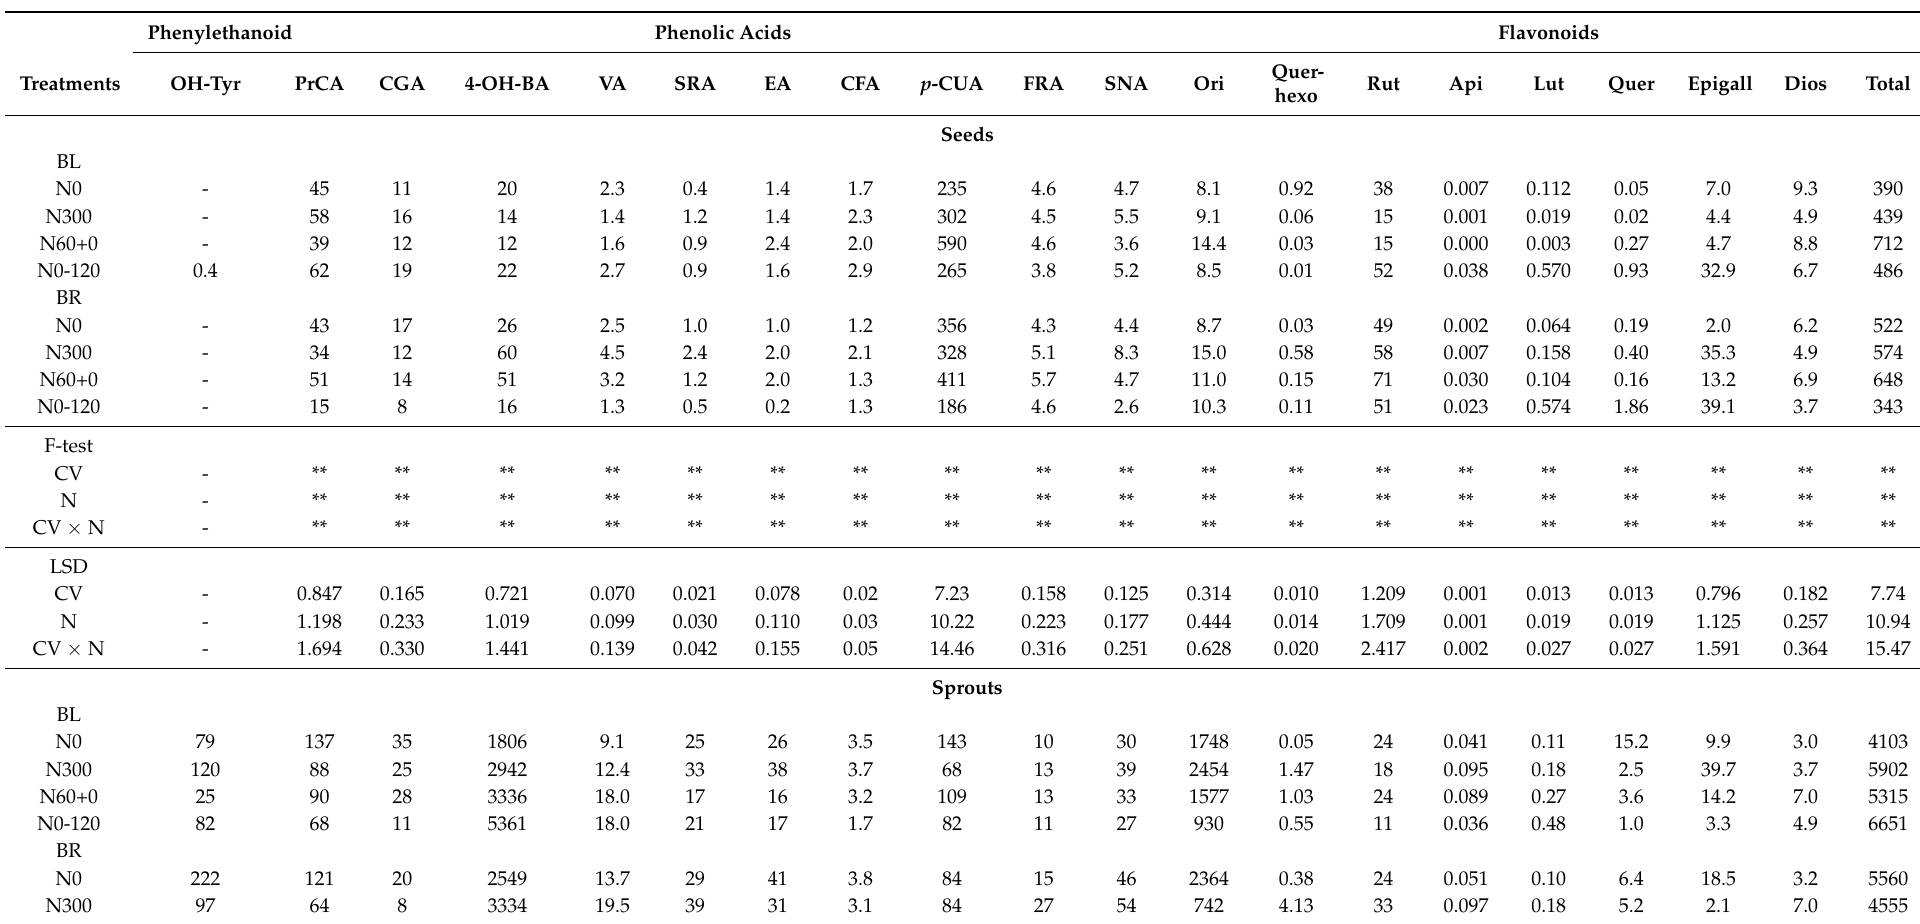
Table 3. Phenolic compounds (hydroxytyrosol—OH-Tyr, protocatechuic acid—PrCA, chlorogenic acid—CGA, 4-hydroxybenzoic acid—4-OH-BA, vanillic acid—VA, syringic acid—SRA, ellagic acid—EA, caffeic acid—CFA, p -coumaric acid— p -CUA, ferulic acid—FRA, sinapic acid—SNA, quercetin—Quer, quercetin-hexoside— Quer-hexo, rutin—Rut, luteolin—Lut, apigenin—Api, diosmetin—Dios, orientin—Ori, epigallocatechin—Epigall) determined by LC-MS/MS in seeds, sprouts, and wheatgrass extracts of two Triticum aestivum cultivars (Bologna, BL; Bora, BR) subjected to four different N fertilization schedules (N0: unfertilized control;